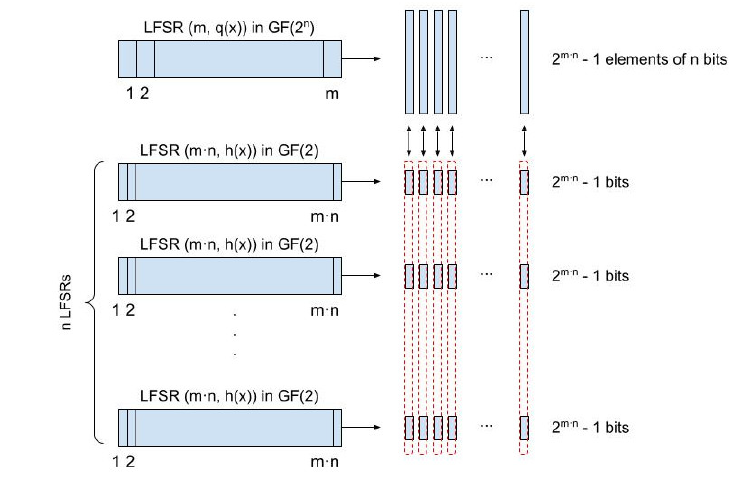
Figure 2. Binary equivalent model of an LFSR in GF ( 2 n )